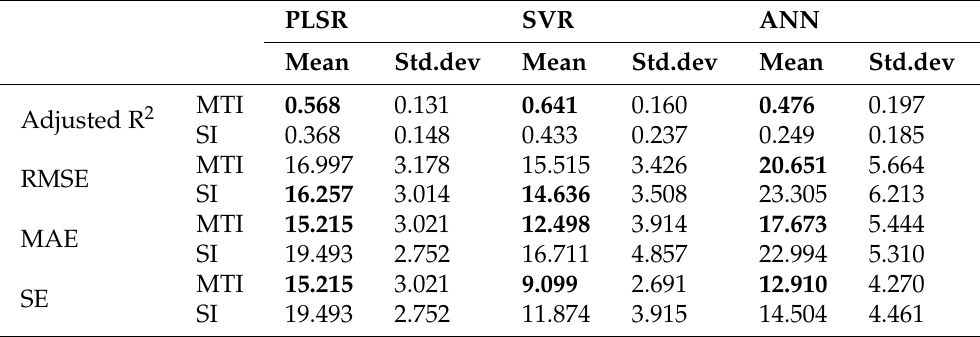
Table 2. The mean and standard deviation values of regression indicators on three regressors over 20 repeated 6-fold cross-validation using MTL and SI on the training dataset and the test